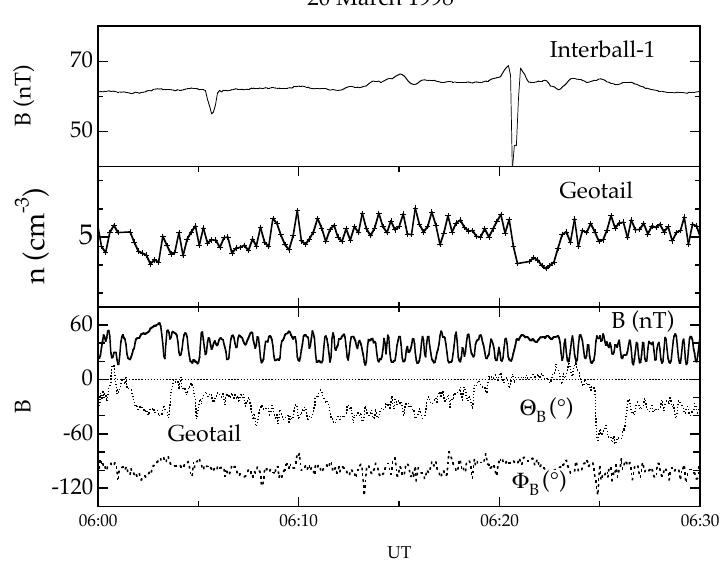
Fig. 5. A comparison of Interball-1 and Geotail observations from 06:00 to 06:30 UT on 20 March 1998. Interball-1 was located in the southern lobe, Geotail in the subsolar magnetosheath. From top to bottom, the figure shows Interball-1 magnetic field strengths, Geotail densities ( n ), magnetic field strength ( B ), GSM latitude ( 2) , and GSM longitude ( 8) . Geotail observed a series of drift mirror mode waves marked by antiphase density and magnetic field strength oscillations. If there was any trigger for the crater FTE at Interball-1, it was a density decrease, magnetic field strength increase, and northward magnetosheath magnetic field